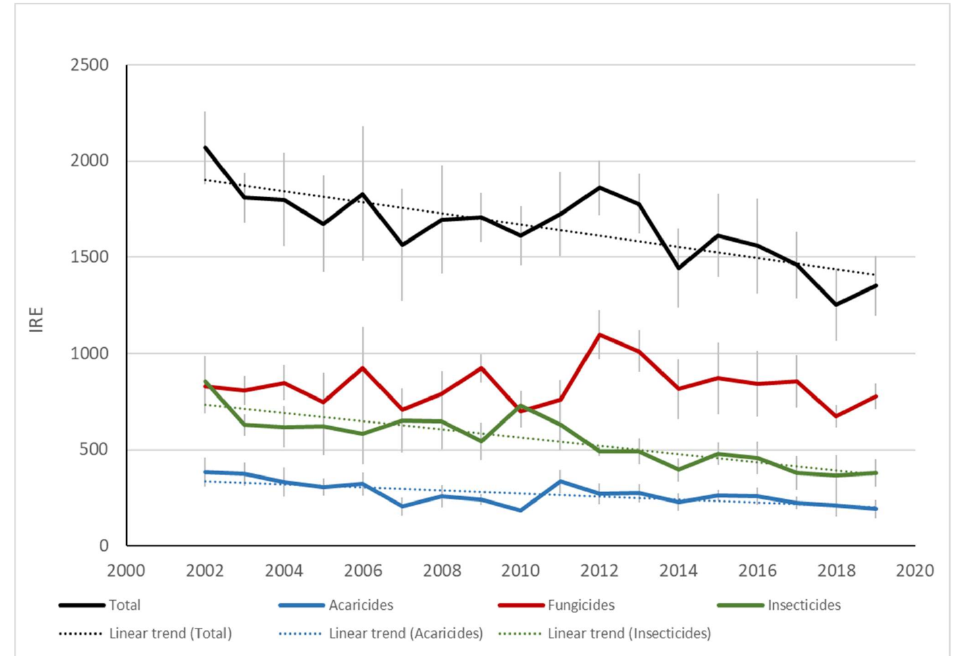
Figure 10. Impact of pesticides as expressed by the Quebec environmental risk indicator (IRE) and estimated annually from treatments applied in commercial orchards from 2002 to 2019 (phase 2). Orchards located at Compton, Dunham, Franklin, Hemmingford, Oka, Sainte-Famille and Saint- Joseph. Vertical bars represent standard error. Only significant trends ( p < 0.05) are